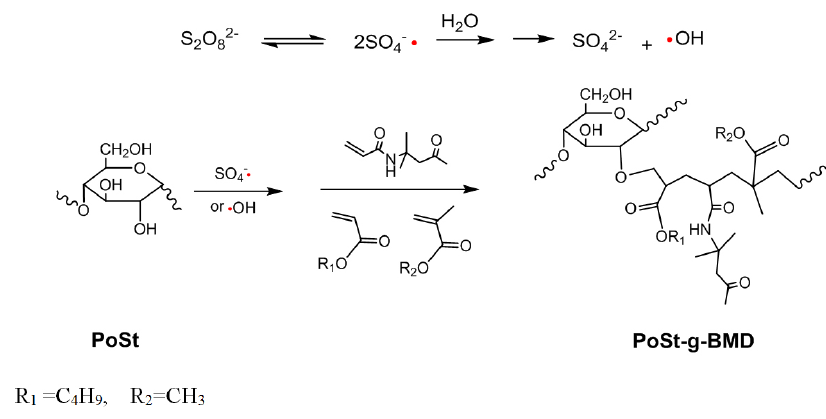
Figure 1. The graft copolymerization of BA, MMA and DAAM on PoSt (R